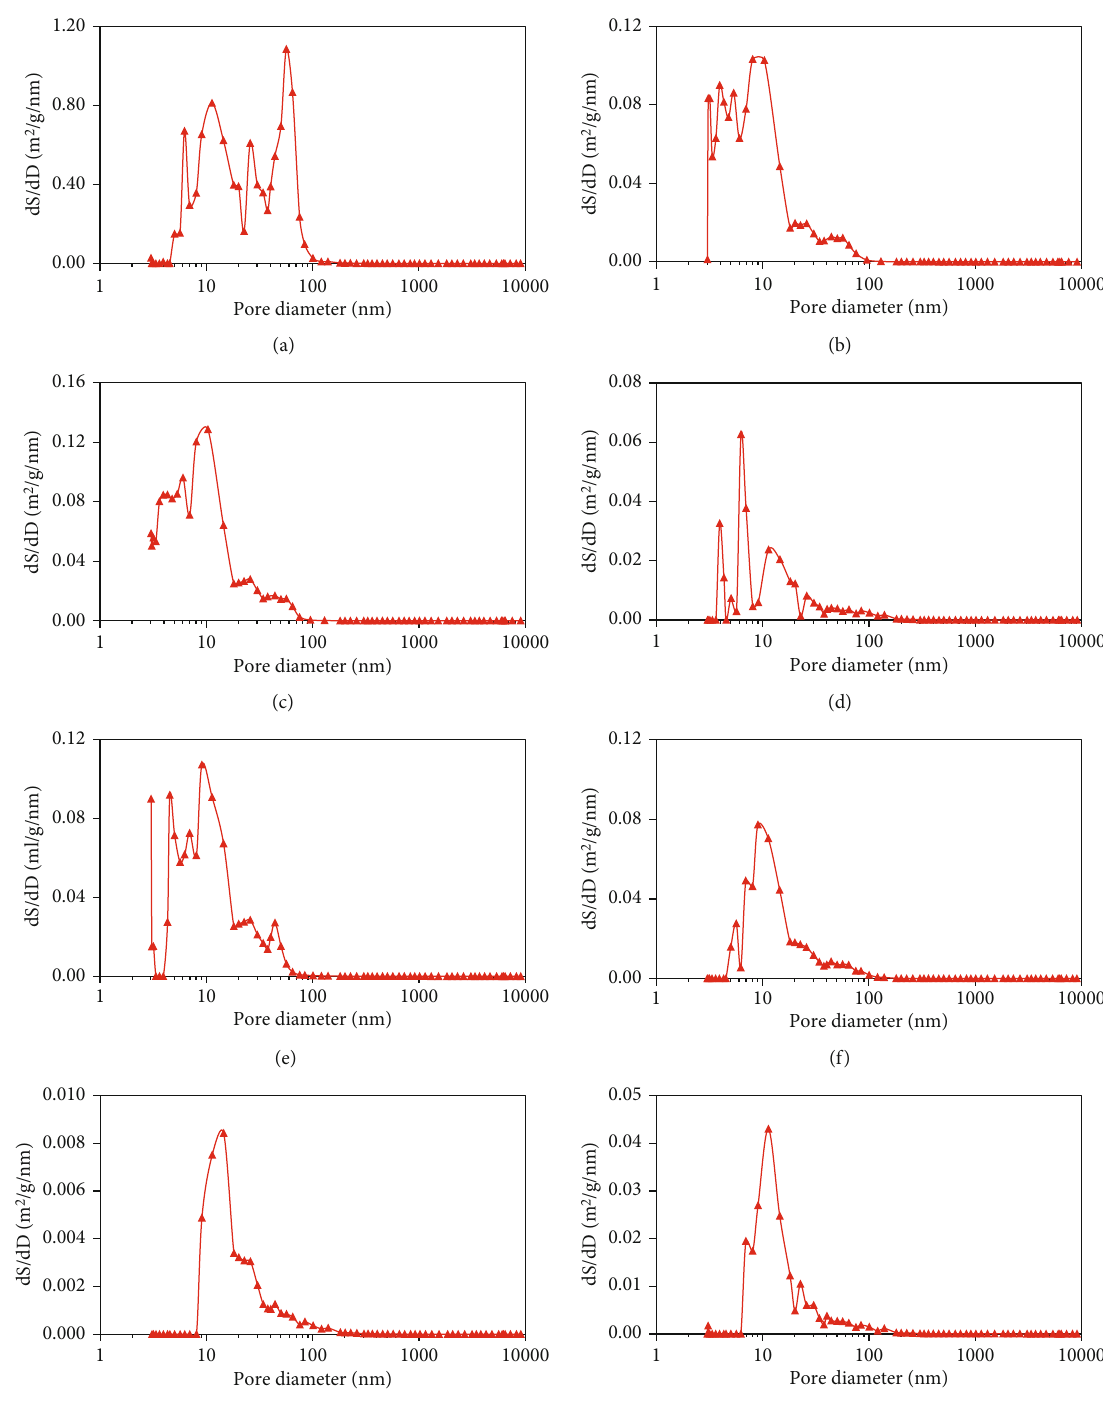
Figure 9: HPMI pore surface area distribution of typical Qigequan Formation mudstone samples. (a) H-1: pure mudstone; (b) H-2: pure mudstone; (c) H-3: pure mudstone; (d) H-4: silty mudstone; (e) H-5: silty mudstone; (f) H-6: silty mudstone; (g) H-7: sandy mudstone; (h) H-8: sandy